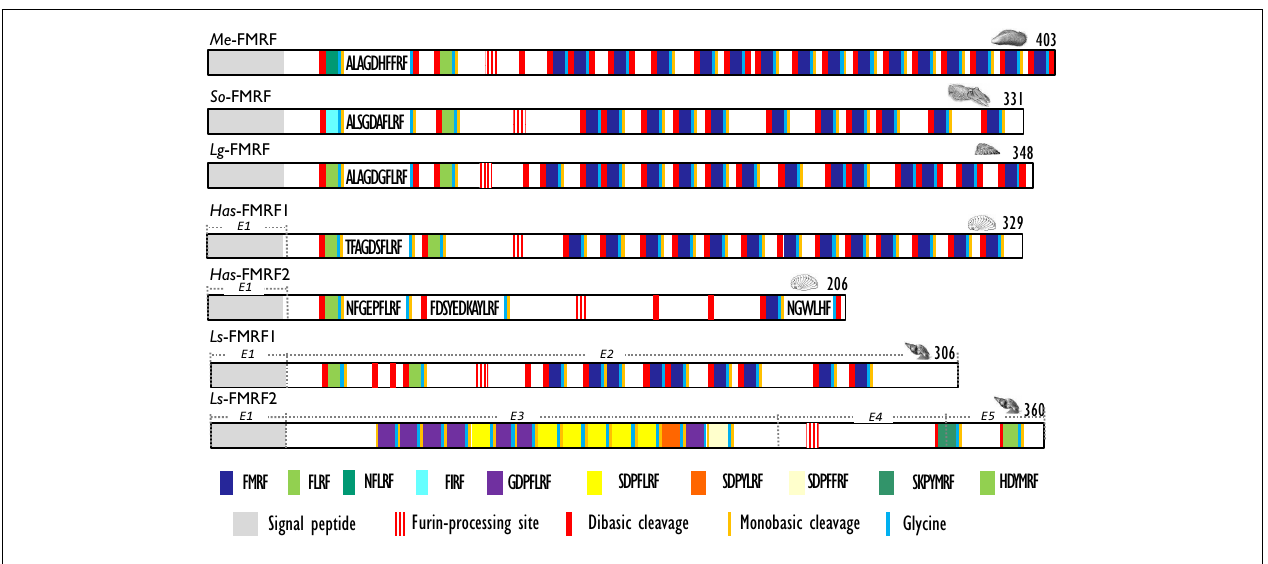
FIGURE 2 | Comparison of the linear schematic organization of FMRFa precursors in mollusks: Me -FMRF identified in Mytilus edulis (25), So -FMRF in Sepia officinalis (24), Lg -FMRF in Lottia gigantea (27), Has -FMRF1 and Has -FMRF2 in Haliotis asinina (28), and Ls -FMRF1 and